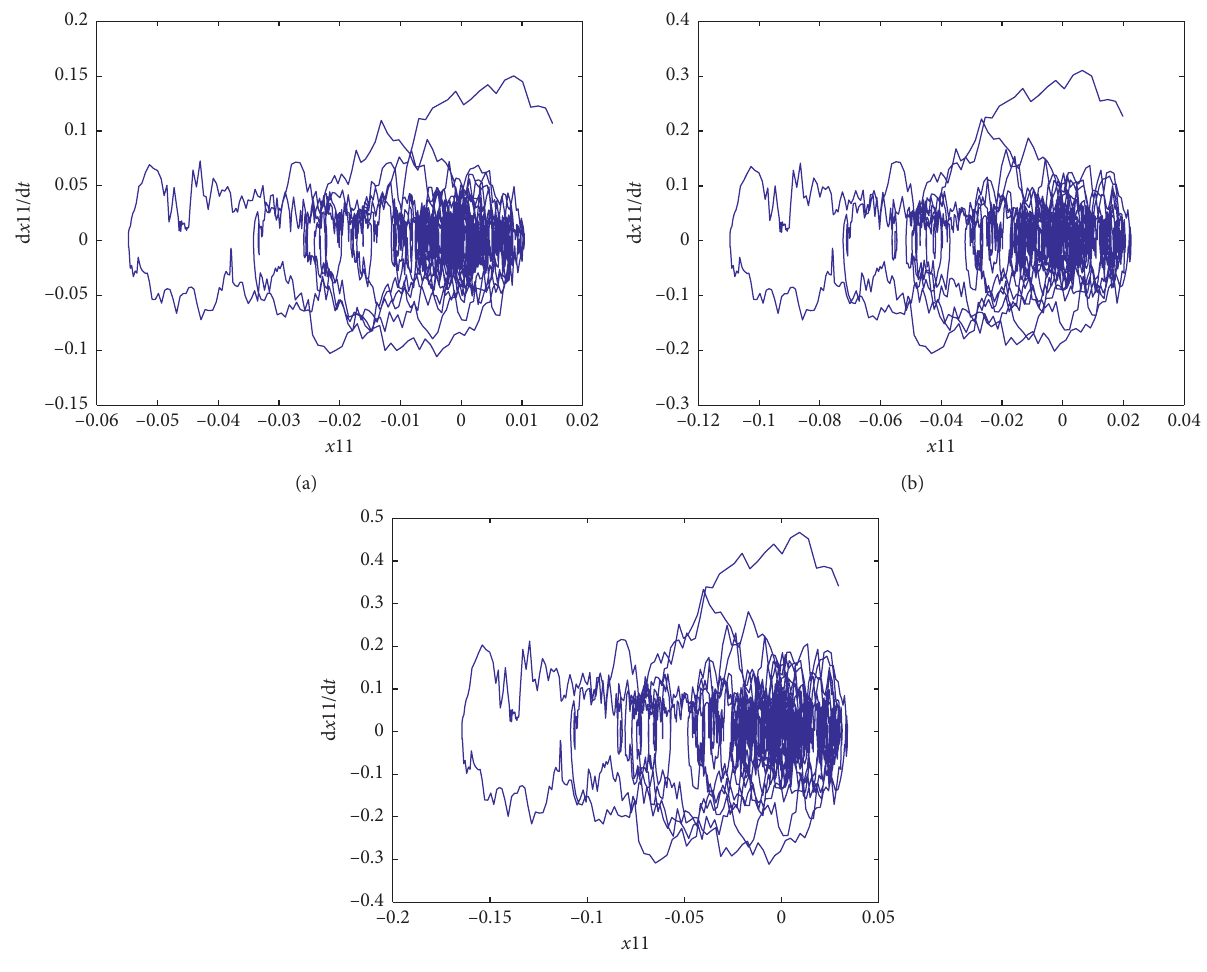
Figure 11: Phase portrait of 11 th story for the controlled case and different h ( x,t ) . (a) h ( x,t ) � 1. (b) h ( x, t ) � 2. (c) h ( x,t ) �